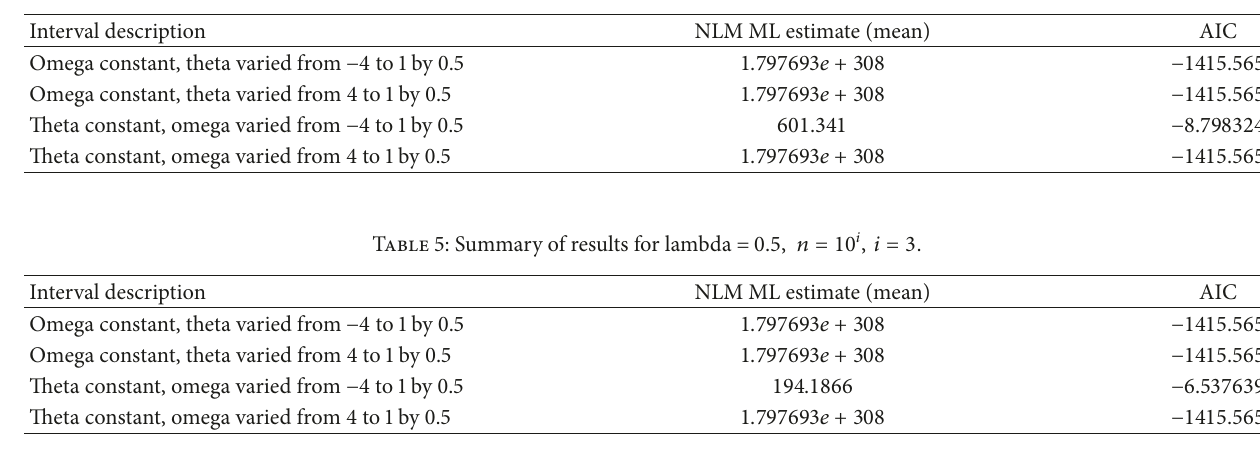
Table 4: Summary of results for lambda = 0.1, 𝑛 = 10 𝑖 , 𝑖 = 3 .